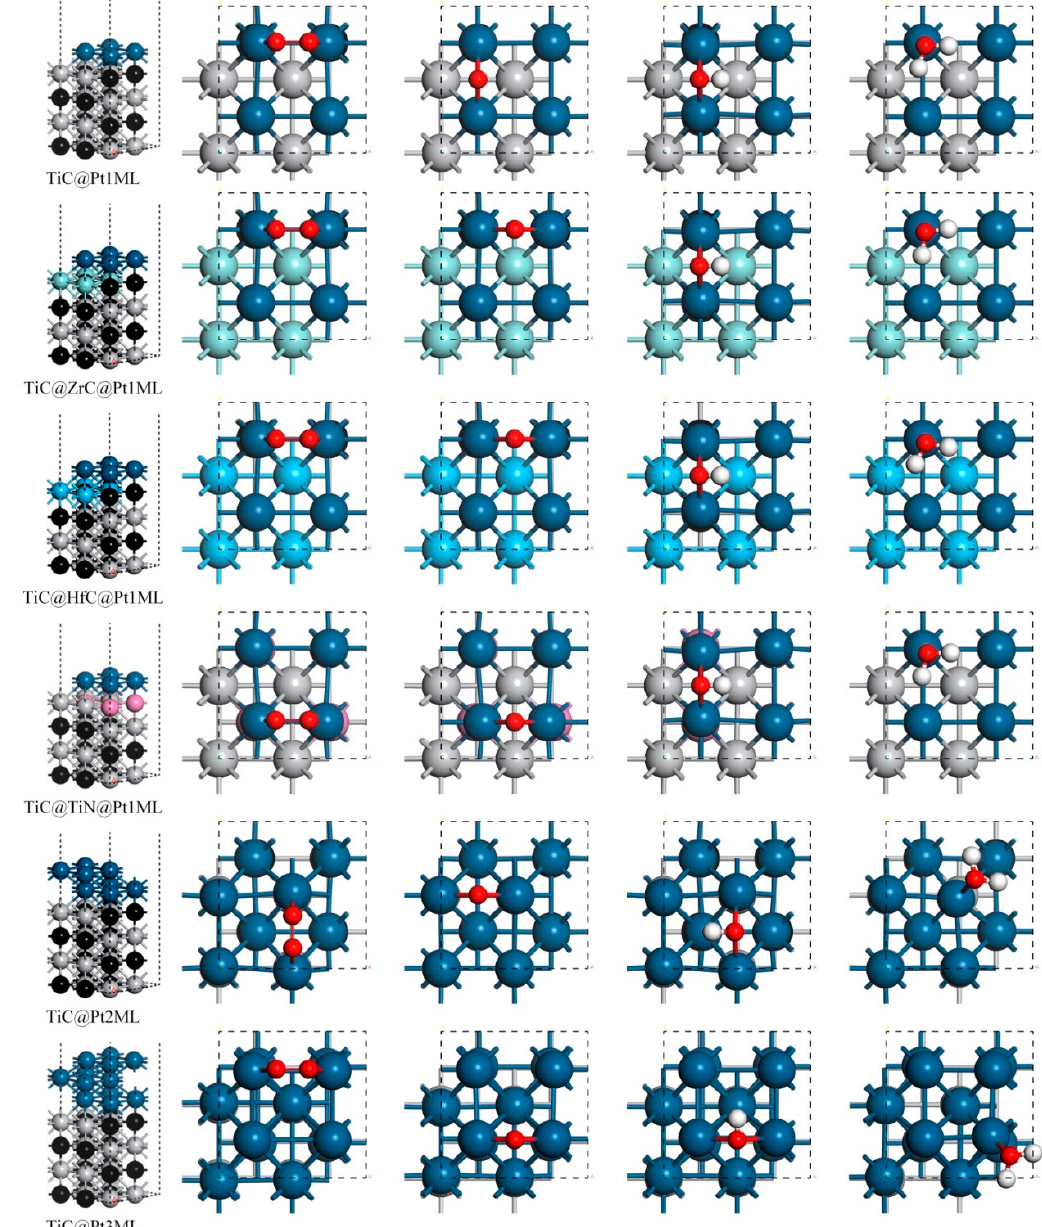
Figure 1. The catalyst structures and the stable adsorption configurations.